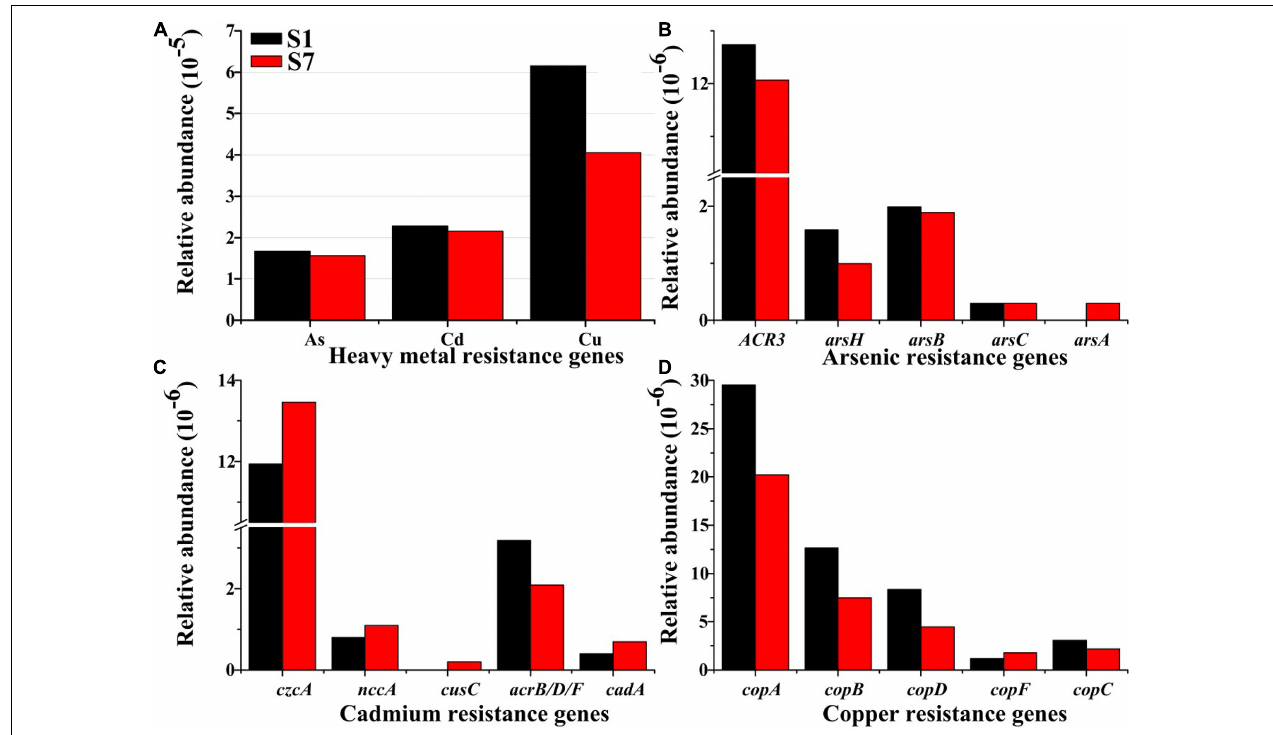
FIGURE 5 | Exposure to heavy metal-contaminated effluent promotes HMRGs in bacterial communities in river sediment. The figure showed the relative abundance of (A) heavy metal resistance genes, (B) As resistance genes, (C) Cd resistance genes, and (D) Cu resistance genes. The relative abundance was calculated in relation to the total number of identified bacterial resistances